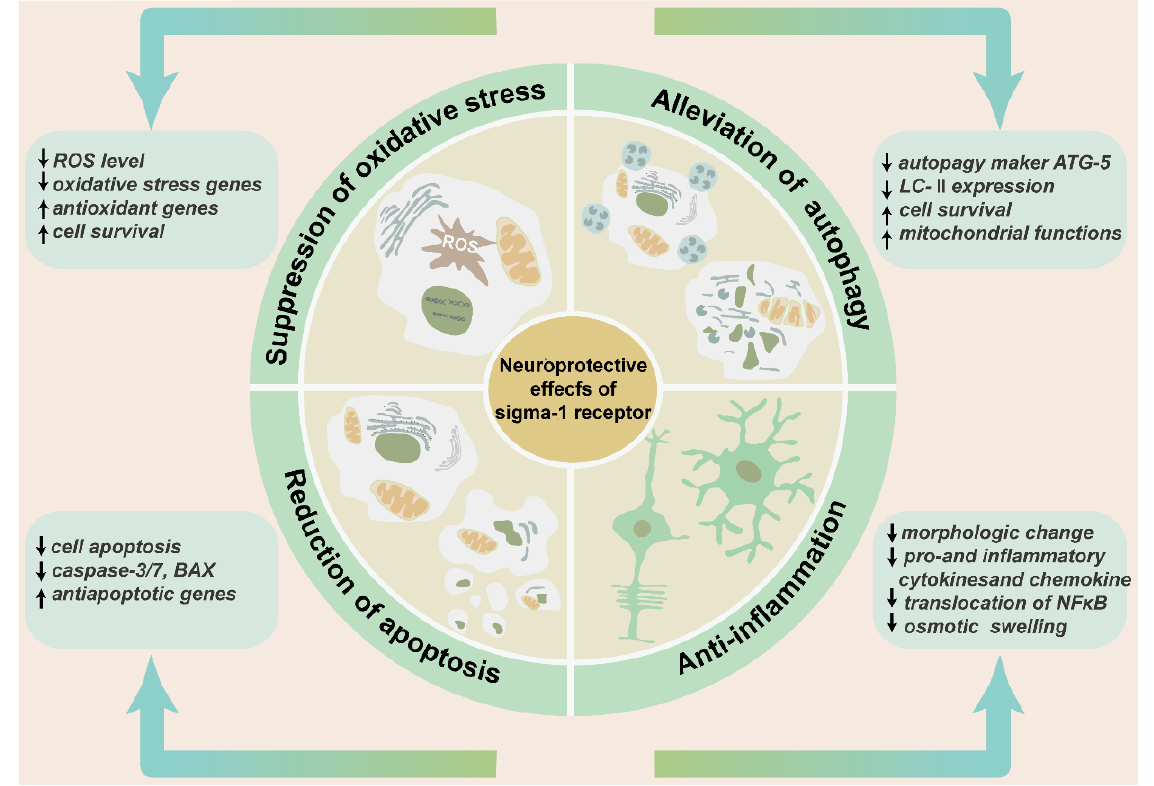
Figure 5. The neuroprotective effects of sigma-1 receptor in retina. The schematic diagram enumer- ates the protective effects of sigma-1 receptor in retina mainly including suppression of oxidative stress, alleviation of pathological autophagy, and reduction of cell apoptosis and anti-inflammation. These effects contribute to preserving retinal thickness and architecture, reducing production of inflammatory factors and inflammatory cells, and enhancing cell survival. Table 1. Ligands of sigma-1 receptor in retinal pharmacological researches. Reference